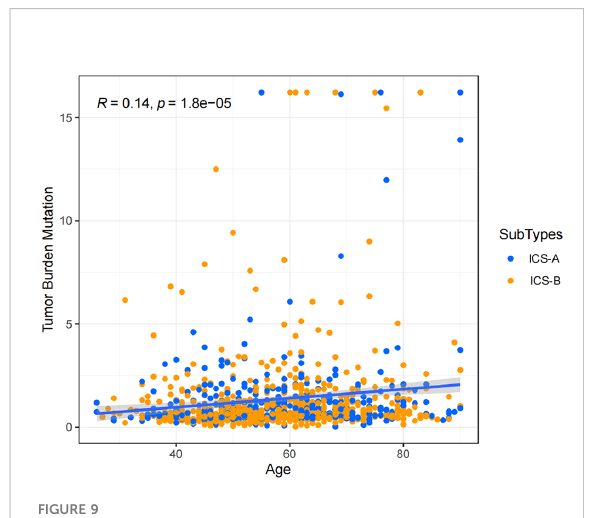
FIGURE 9 Tumor mutational burden (TMB) correlation analysis with